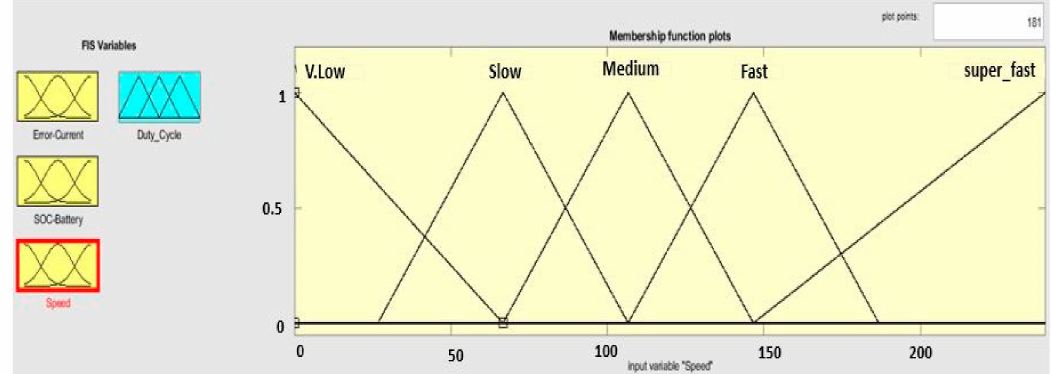
Figure 10. Membership functions for speed of BLDC motor.